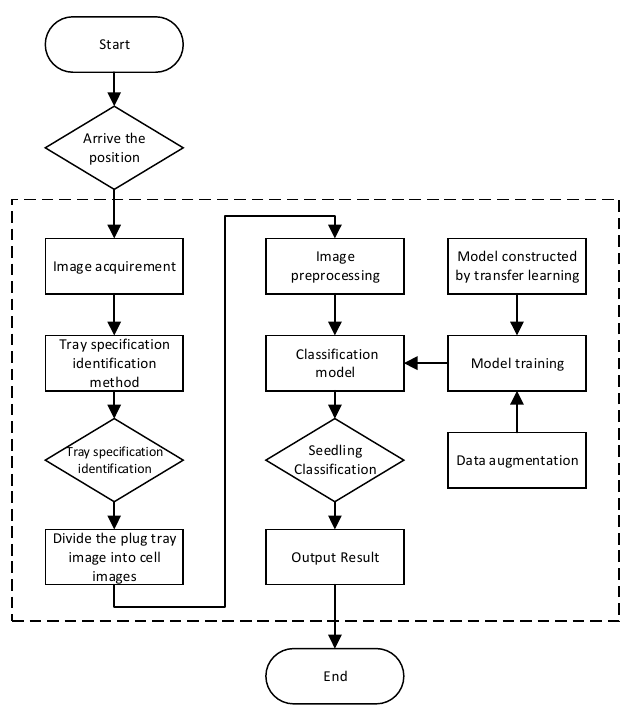
Figure 2. Main steps involved in the classification of plug seedlings.